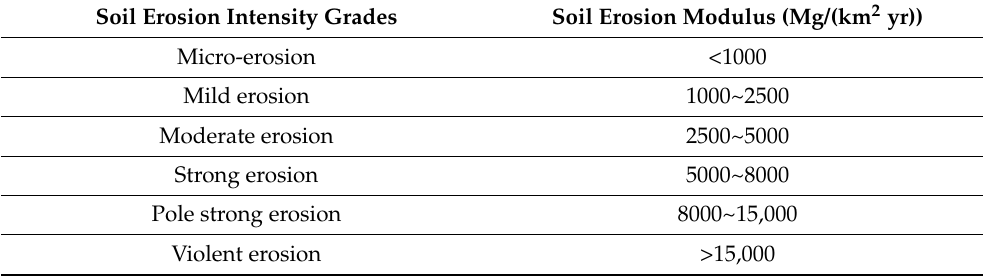
Table 4. Classification standard of soil erosion intensity grades [32].